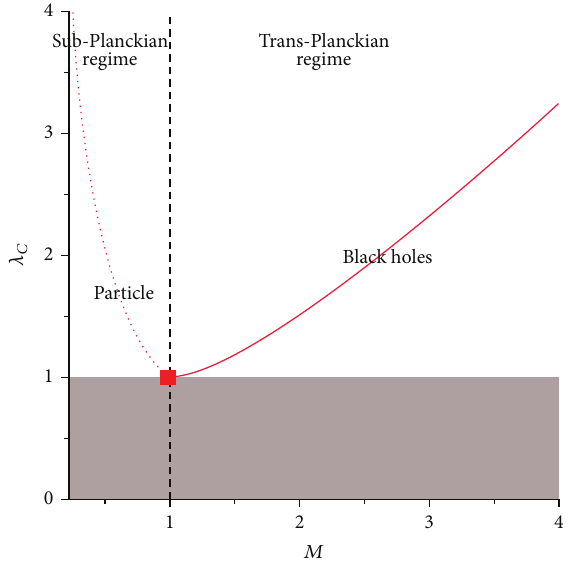
Figure 2: The plot shows a length/energy relation consistent with the self-complete quantum gravity arguments in Planck units. Particles (dotted line) and black holes (solid line) cannot probe length shorter than the Planck length. The grey area is permanently inaccessible and accordingly represents the minimal spacetime time region or fundamental constituent, that is, the “atom” the spacetime is supposed to be made